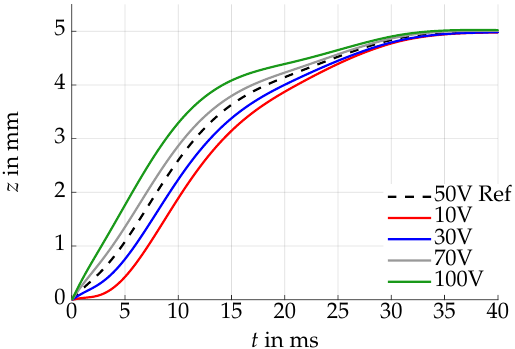
Figure 8. Feedback control simulation compensating for initial state uncertainty. The expected initial state resulting in the reference trajectory (dashed, black) for 50V is not achieved due to incorrect kick voltages. Feedback control compensates this error and the proof mass motion asymptotically converges to the desired trajectory for different piezo voltages.